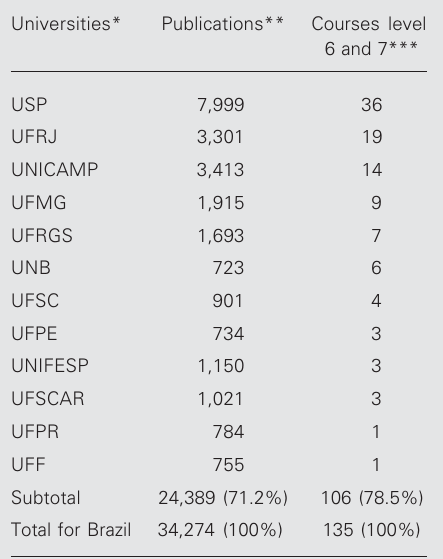
Table 3. . . . . Publications (1997 to 2000) and outstand- ing graduate